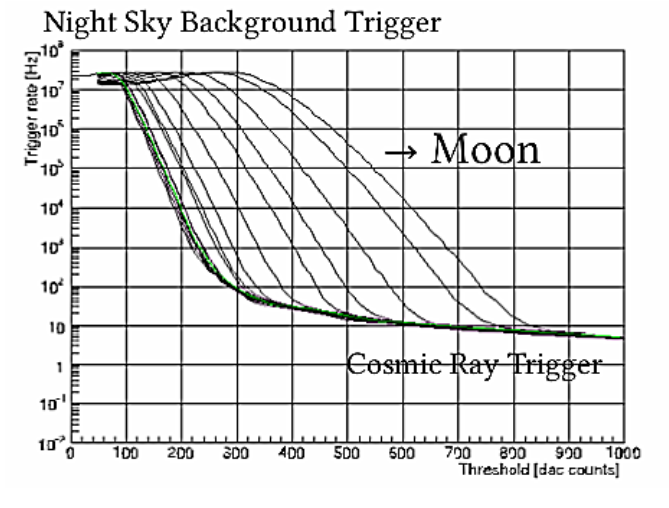
Figure 3. Ratescans (scans of the trigger rate versus the applied trigger threshold) under different light conditions. Black: 2012, Green: